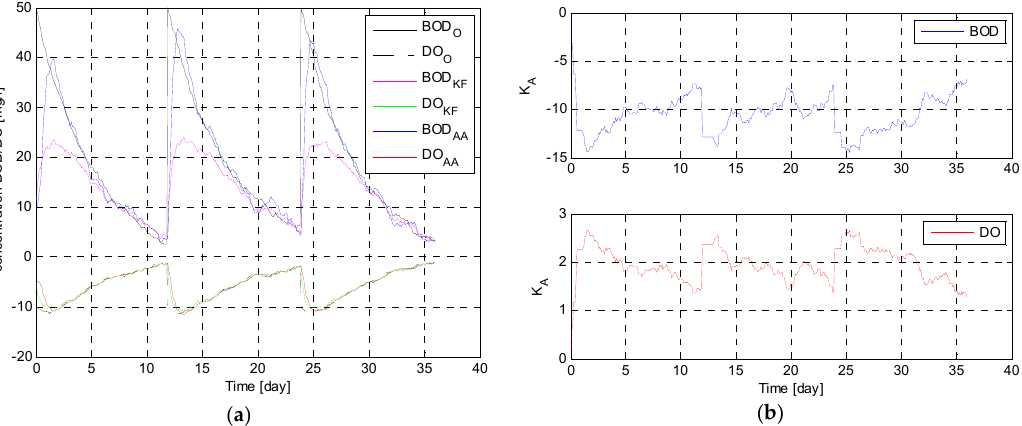
Figure 9. Distribution of BOD and DO signals ( a ) and adaptive algorithm gain coefficients ( b ) for matrices W = [6, -4; -4, 2] and V = [0.1].